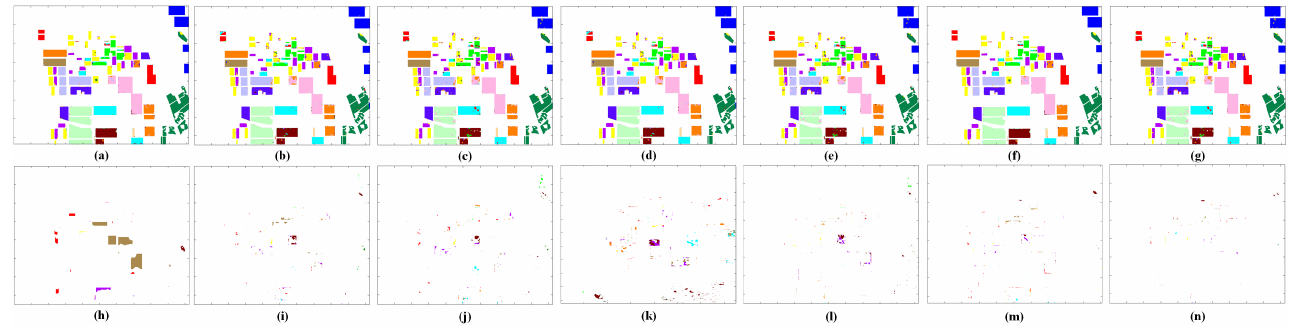
Figure 8. Crop classification results for different classifiers ( a ) SVM, ( b ) SAE-CNN, ( c ) 3D CNN, ( d ) 1D CNN, ( e ) LSTM, ( f ) ViT, ( g ) FTDN; ( h – n ) the error maps of ( a – g